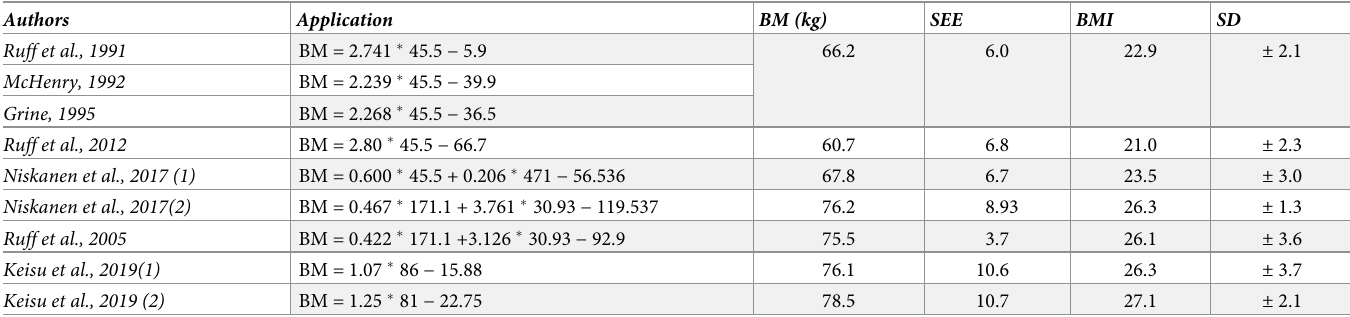
Table 2. Body mass and body mass index of St Anthony of